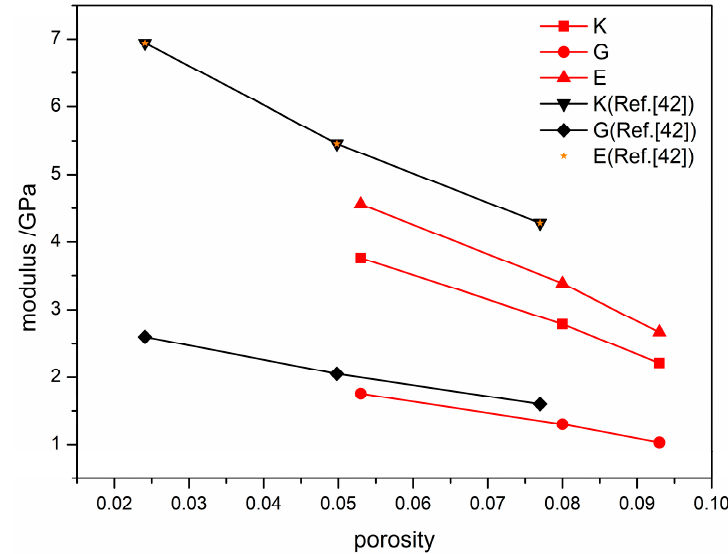
Figure 8. Modulus curve of PBX at di ff erent porosities, as well as experimental data from reference [41], K = bulk modulus, G = shear modulus, and E = Young’s modulus.